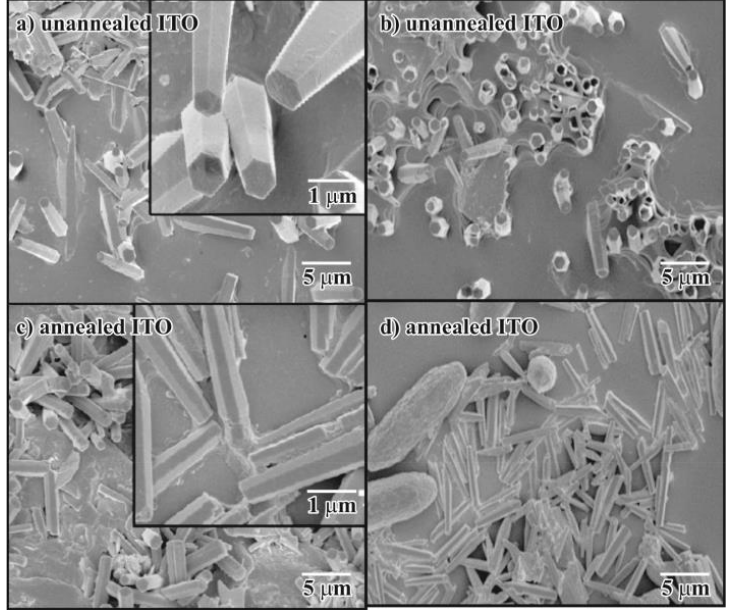
Figure 5. Field-emission scanning electron microscopy (FE-SEM) images of ZnO nanowires grown on ITO-coated glass substrates: ( a , b ) non annealed, ( c , d ) annealed. The inset images ( a , c ) show the side views of the ZnO nanowires [112].